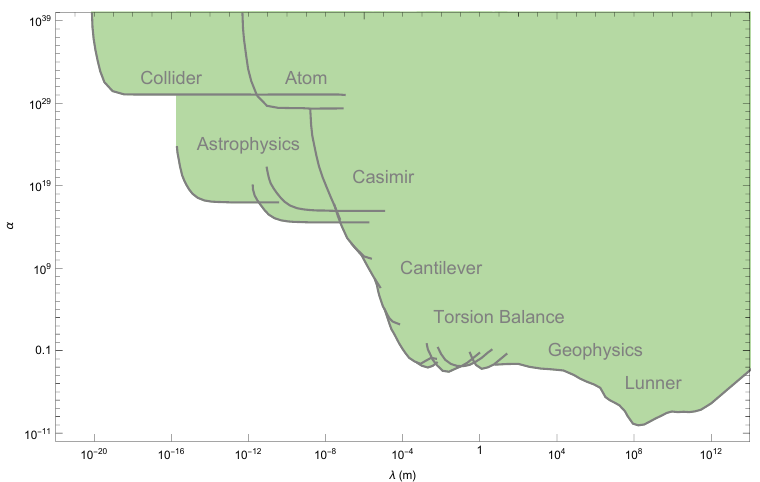
Figure 8 . Experimental constraints on the parameters α (coupling strength) and λ (range) of a Yukawa-type interaction, with the shaded area indicating the excluded region of parameter space at 95% confidence level. figure adapted from [23, 64]. See [23, 64] for details and further